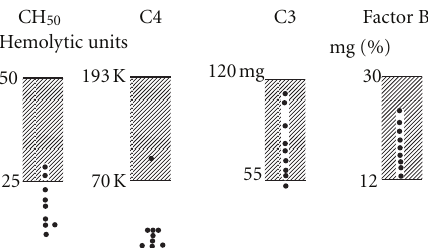
Figure 1: C3, C4, and factor Bb levels determined by hemolytic assay in patients with type 2 MC